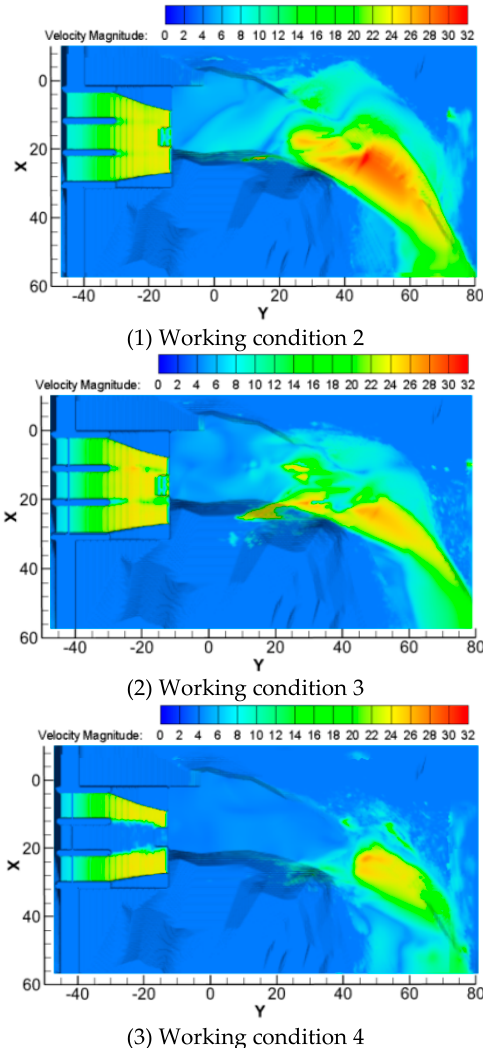
Figure 13. Near-bottom flow velocity on the spillway surface and the downstream channel.